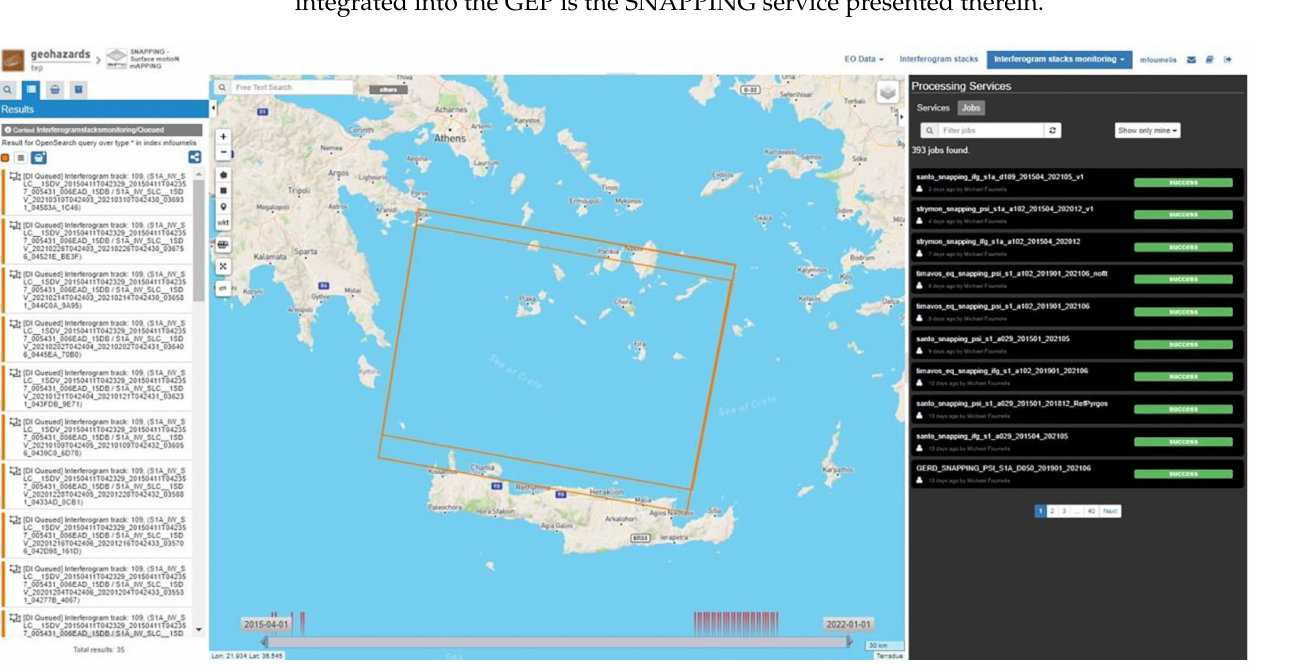
Figure 2. The GEP geobrowser showing the online graphical interface featuring tools for EO data searches, execution of services, and visualization of the results. The various EO services and already submitted jobs appear on the right panel, whereas catalog searches and results are shown on the left panel. The Interferogram Stack Monitoring tab (shown here in blue on top right corner) provides information on the status of successfully submitted IFG jobs (pairs generation; queued, on-going, completed, and failed). The status of submitted PSI runs can be checked through the status bar of each